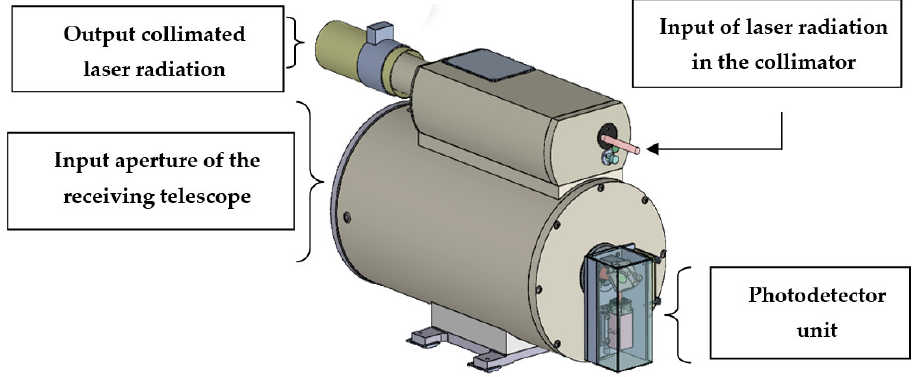
Figure 5. Modernized transceiver of the mobile airborne lidar (collimator and receiving unit).